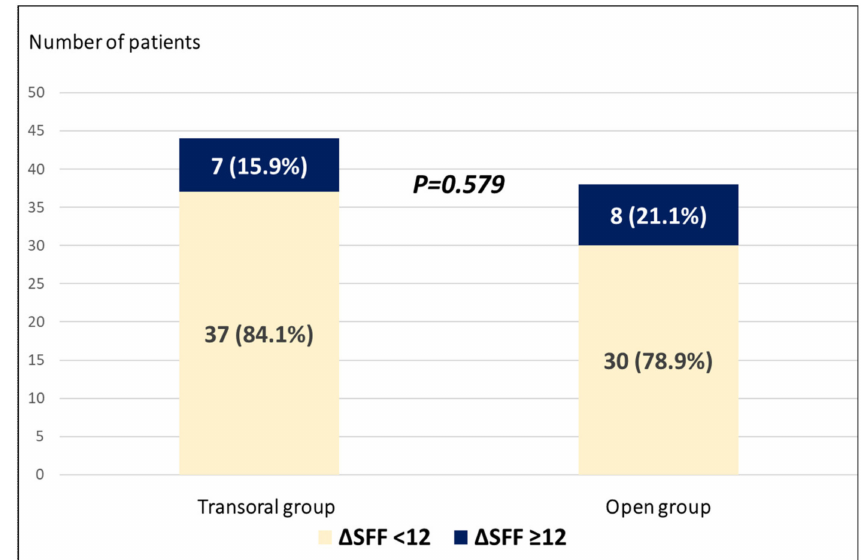
Figure2. TheproportionsofpatientswhoexhibitedclinicalchangesintheSFF( ∆ SFF ≥ 12)aftertransoral endoscopic thyroidectomy vestibular approach (TOETVA) or open thyroidectomy. Abbreviations: SFF, speech fundamental frequency; di ff erence ( ∆ ), preoperative value − postoperative value; TOETVA, transoral endoscopic thyroidectomy vestibular approach; Open, open